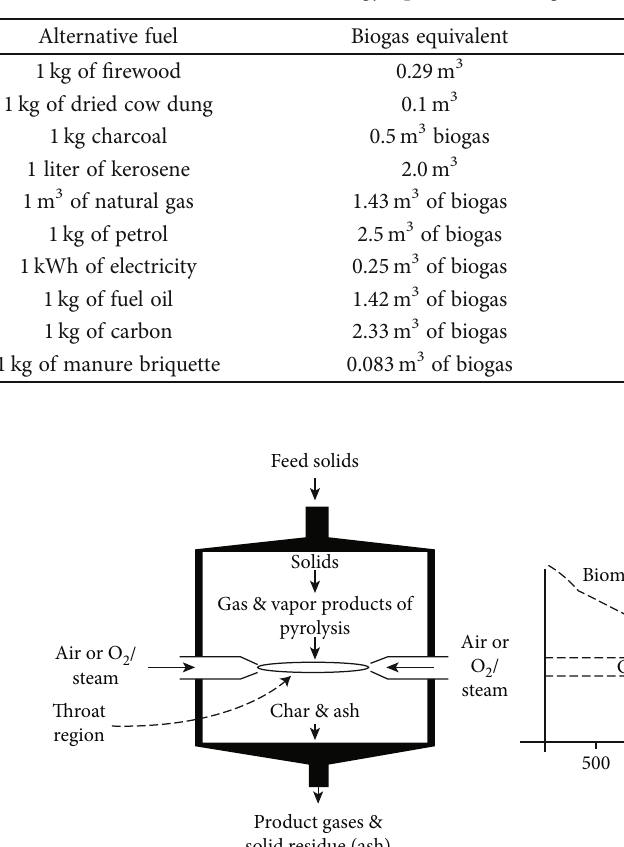
Table 7: Energy equivalents of biogas [43, 75, 116].